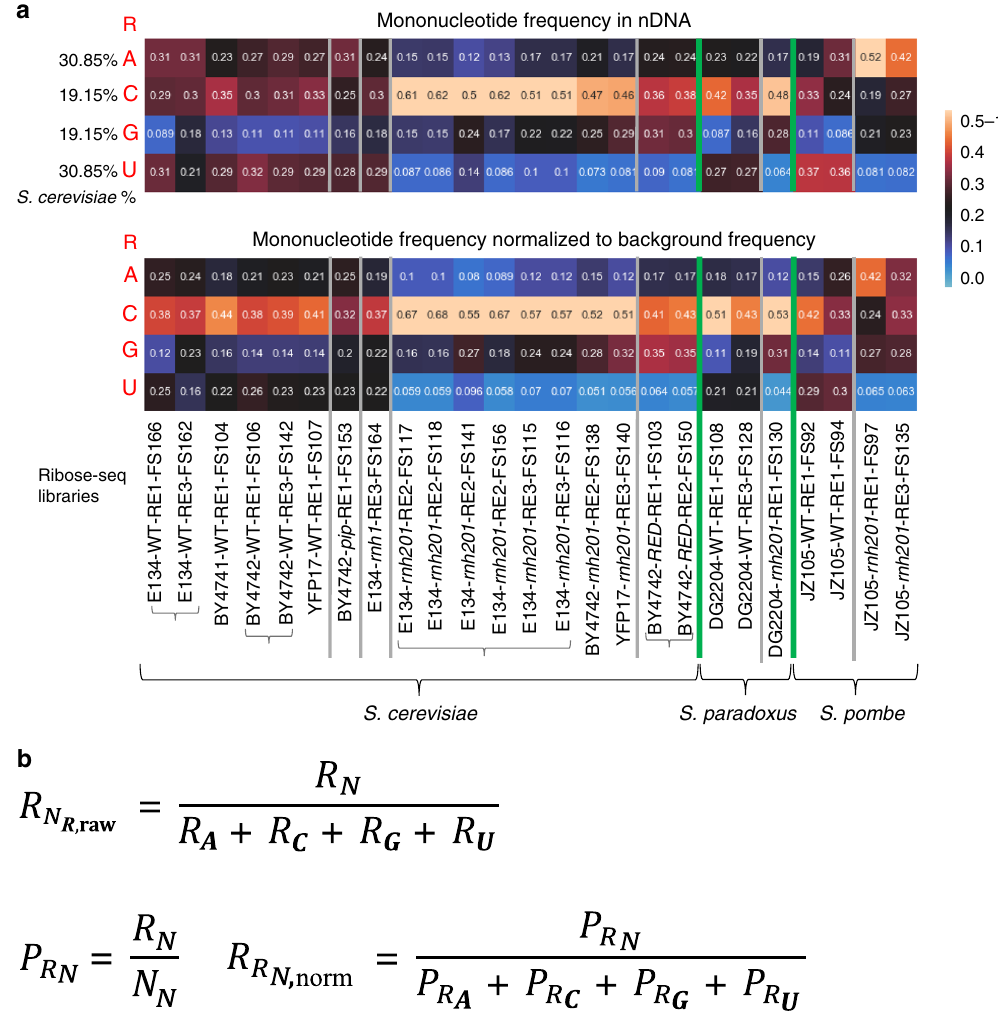
Fig. 6 Heatmap analyses of rNMPs in yeast nuclear DNA. a Heatmap analyses with (top) frequency of each type of rNMP (rA, rC, rG, and rU), and (bottom) frequency of each type of rNMP normalized to the nucleotide frequencies of the corresponding reference genome for all the nucleus ribose-seq libraries of this study. The corresponding formulas used are shown in b and explained in Methods. Each column of the heatmap shows results of a speci fi c ribose-seq library. Each library name is indicated underneath each column of the heatmap with its corresponding strain name, genotype, and restriction enzyme (RE) set used. The yeast species of the ribose-seq libraries are also indicated. S. cerevisiae libraries derived from the same strains are grouped together by curly brackets. Thick, vertical, green lines separate data from the different yeast species. Vertical gray lines separate data obtained from different RNase H genotypes within each species. Each row shows results obtained for an rNMP (R in red) of base A, C, G, or U for each library. The actual percentages of A, C, G, and T bases present in nDNA of S. cerevisiae are shown to the left of the top heatmap, and are also indicated in Supplementary Data 2A. The corresponding base percentages for nDNA of S. paradoxus and S. pombe are indicated in Supplementary Data 2B and 2C, respectively. The bar to the right shows how different frequency values are represented as different colors: black for 0.25; black to yellow for 0.25 to 0.5 – 1, and black to light blue for 0.25 to 0. b Formulas used to calculate the frequency and the normalized frequency values of the nuclear heatmaps in a , see explanations in